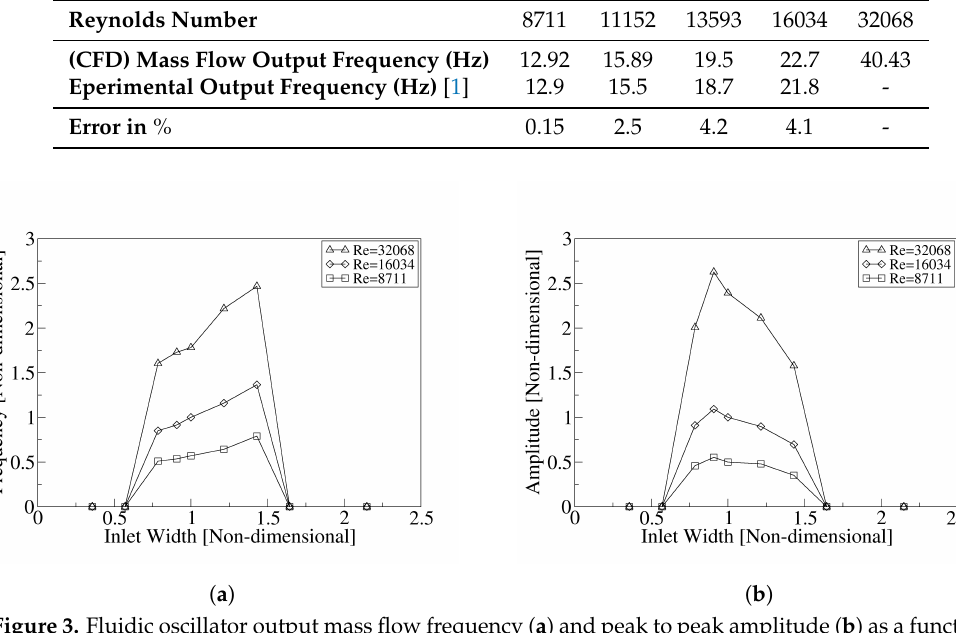
Table 1. Comparison experimental and simulated results.